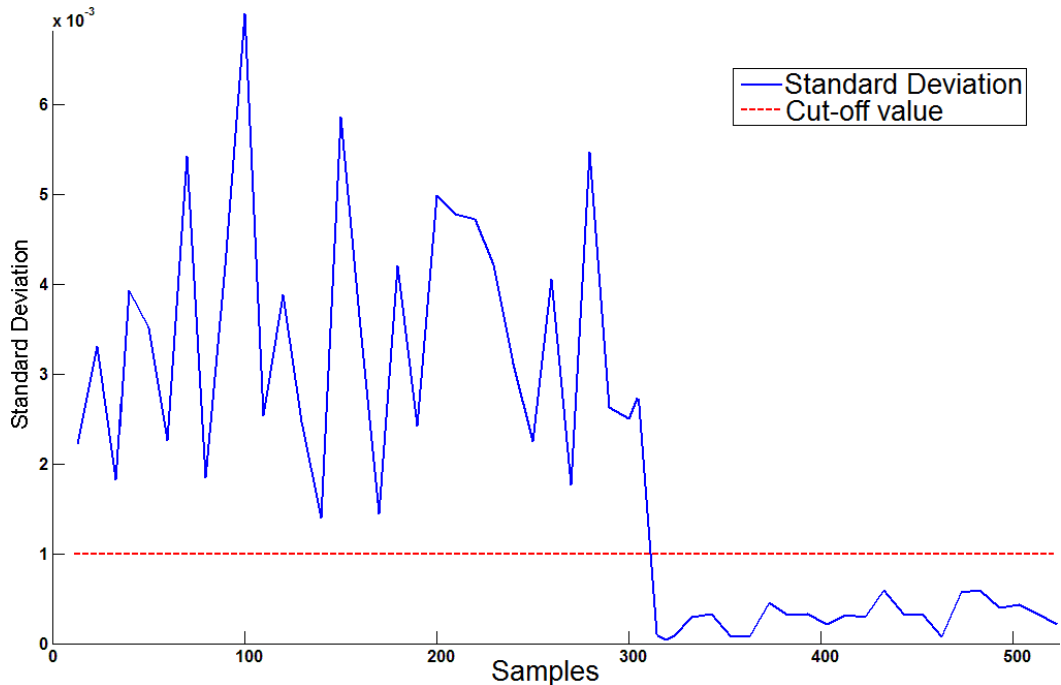
Figure 4. A cut-off value can separate the standard deviation of the measured weight signal into in-bed signals and out-of-bed